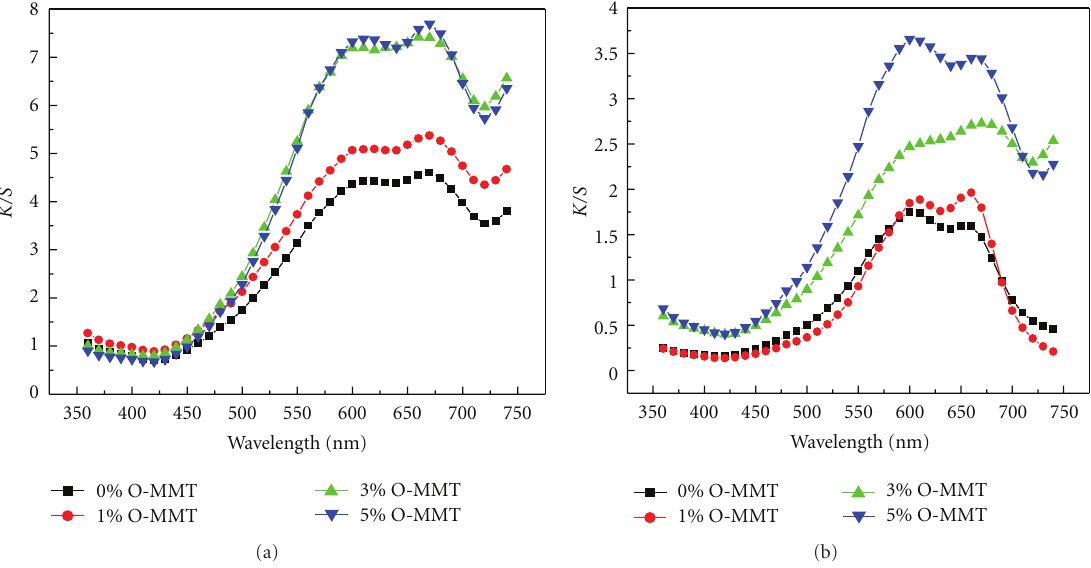
Figure 7: K/S curves of the PAN composite nanofibers with di ff erent mass ratios of O-MMT before (a) and after (b) photocatalytic process: the substrate is PAN/O-MMT composite nanofibrous membranes coated with three layers of TiO 2 .